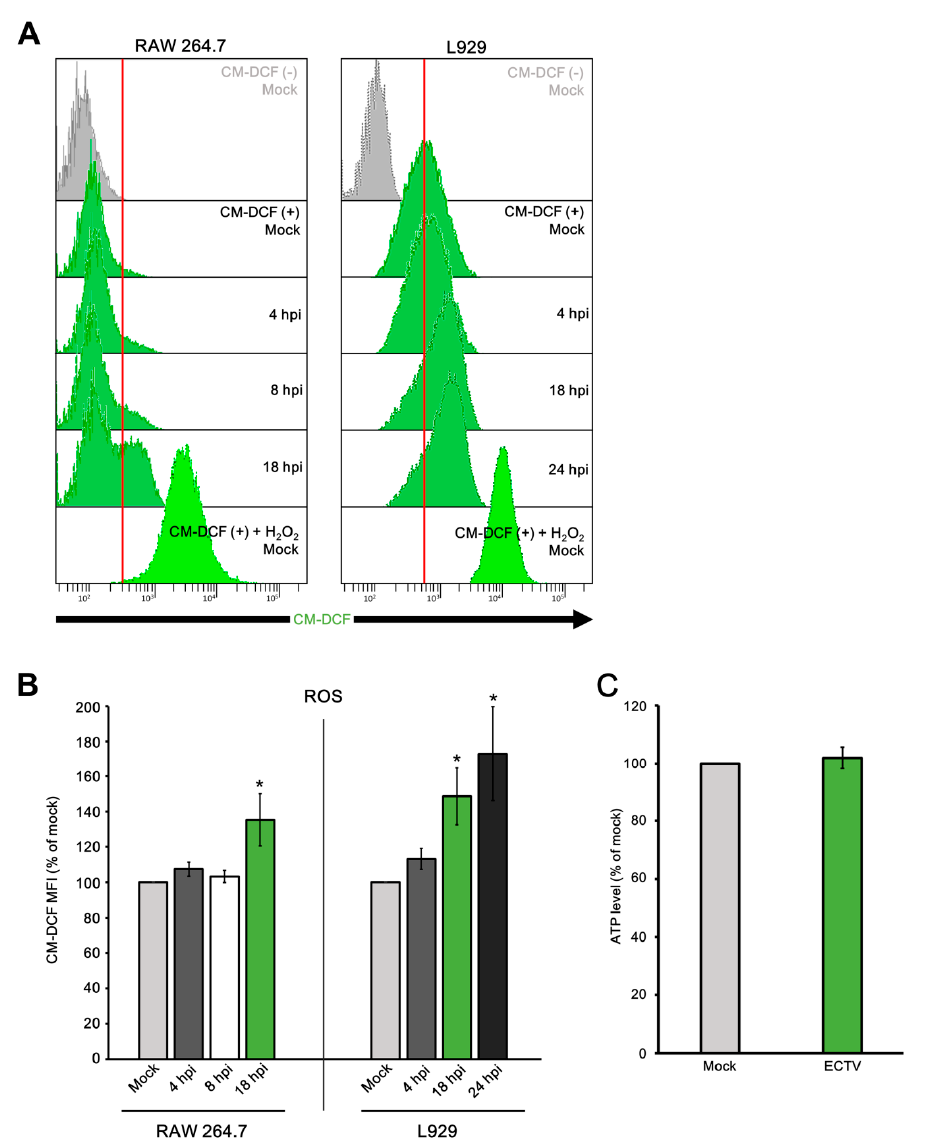
Figure 14. Level of reactive oxygen species (ROS) and ATP in RAW 264.7 and/or L929 cells during ECTV infection. ( A ) Representative histograms of flow cytometry analysis of 5-(6)-chloromethyl-2 ′ ,7 ′ - dichlorofluorescein (CM-DCF) staining in RAW 264.7 and L929 cells during ECTV infection. Grey populations indicate no-stain mock cells. Mock cells stained with CM-DCF were used as a negative control. Mock cells treated with H 2 O 2 and stained with CM-DCF were used as a positive control. ( B ) Mean fluorescence intensity (MFI) of CM-DCF at 4, 8, and 18 hpi in RAW 264.7 macrophages and at 4, 18, and 24 hpi in L929 fibroblasts. Data from three independent experiments are presented as mean ± SD ( n = 10,000 cells). Student’s t -test; * p ≤ 0.05. ( C ) Level of ATP in control and ECTV-infected L929 fibroblasts at 18 hpi.